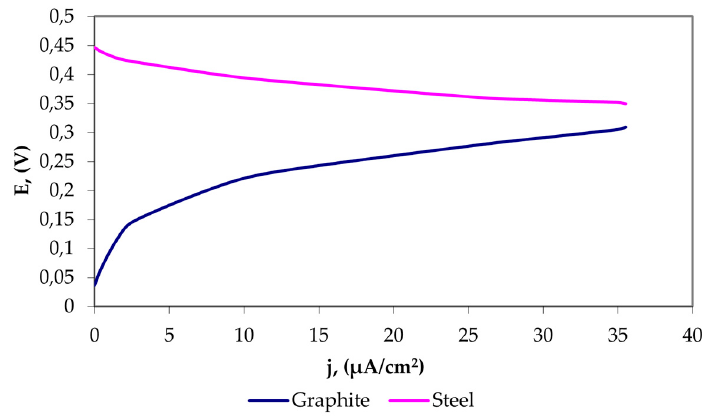
Figure 7. Corrosion diagram of a steel sample with phosphate coating from a solution with the addition of zinc nitrate.